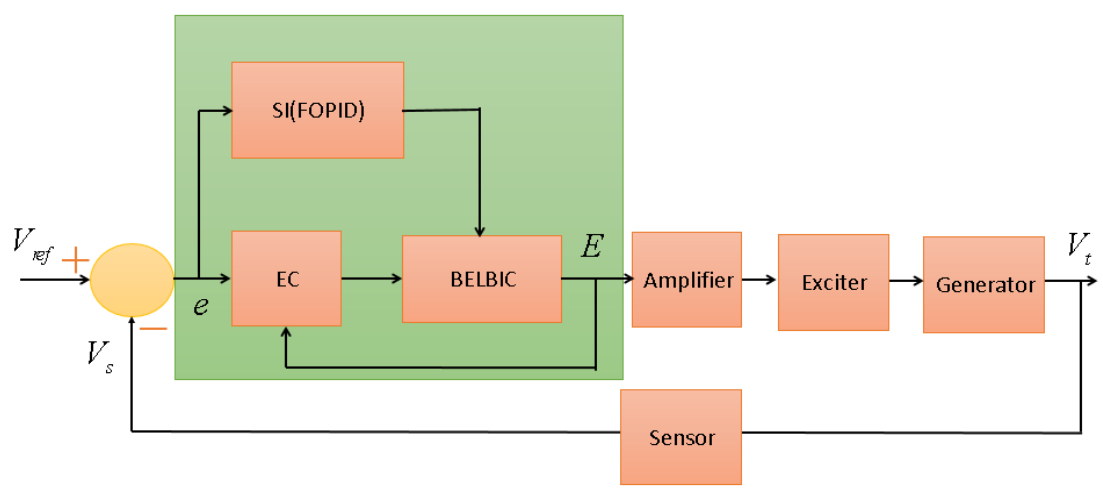
Figure 1. Block diagram of an AVR system with controller.